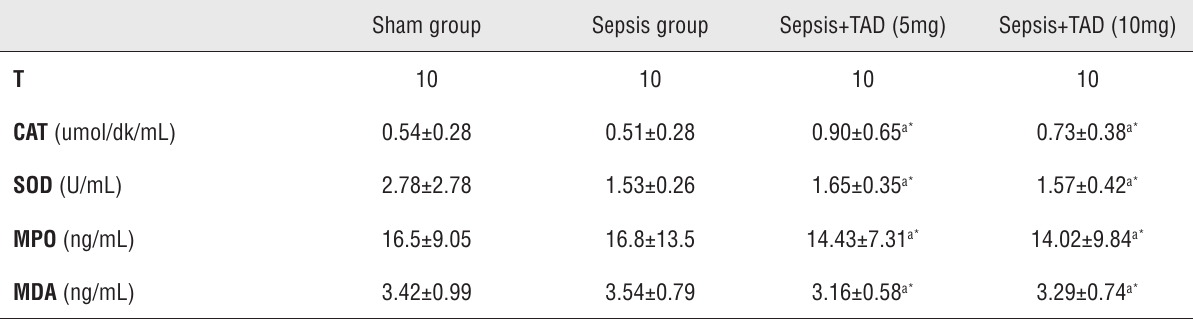
Table 2 - Effect of tadalafil on CAT, SOD, MPO and MDA levels in rat serum with sepsis.